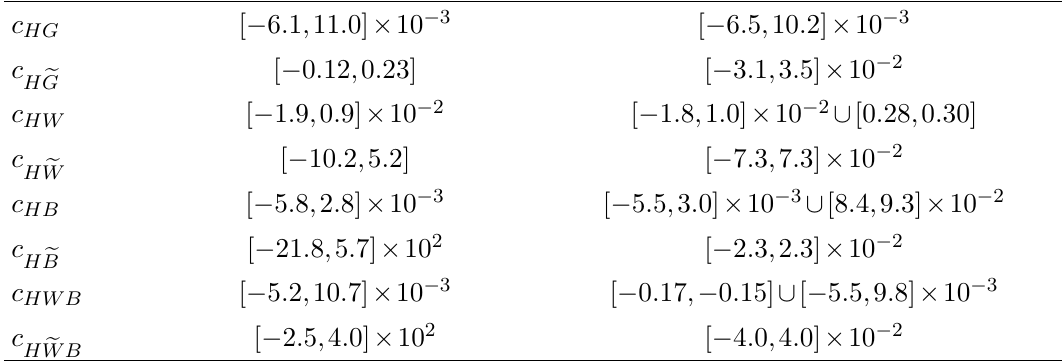
Table 7. The 95% CL observed limits on the c HG , c HW , c HB , c HWB Wilson coefficients of the SMEFT basis and their CP-odd counterparts using interference-only terms and using both the interference and quadratic terms. Limits are derived by fitting one Wilson coefficient at a time while setting the other coefficients to zero. The limits are computed at a new-physics scale Λ = 1 TeV .